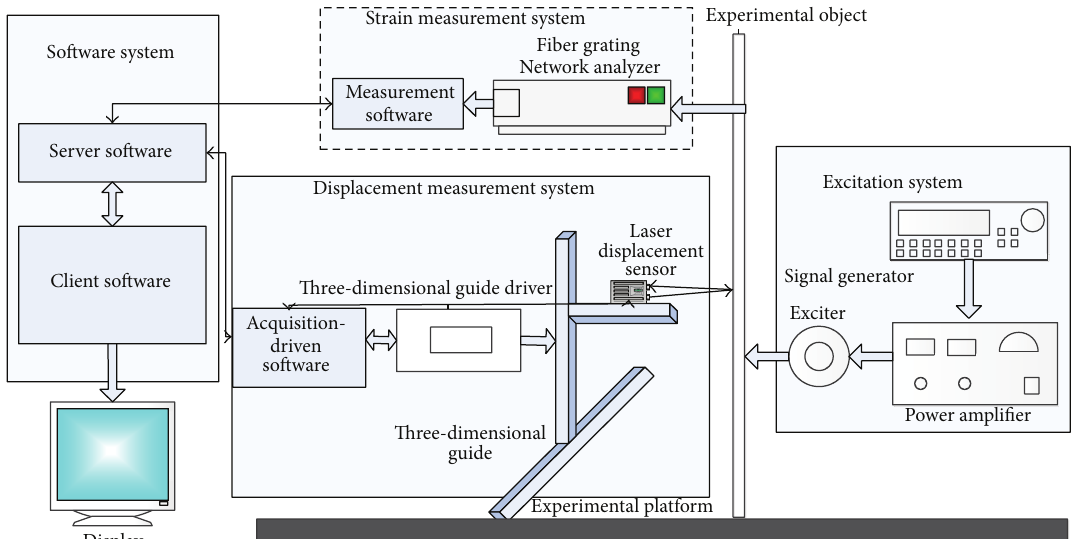
Figure 12: Schematic diagram of the experimental platform.